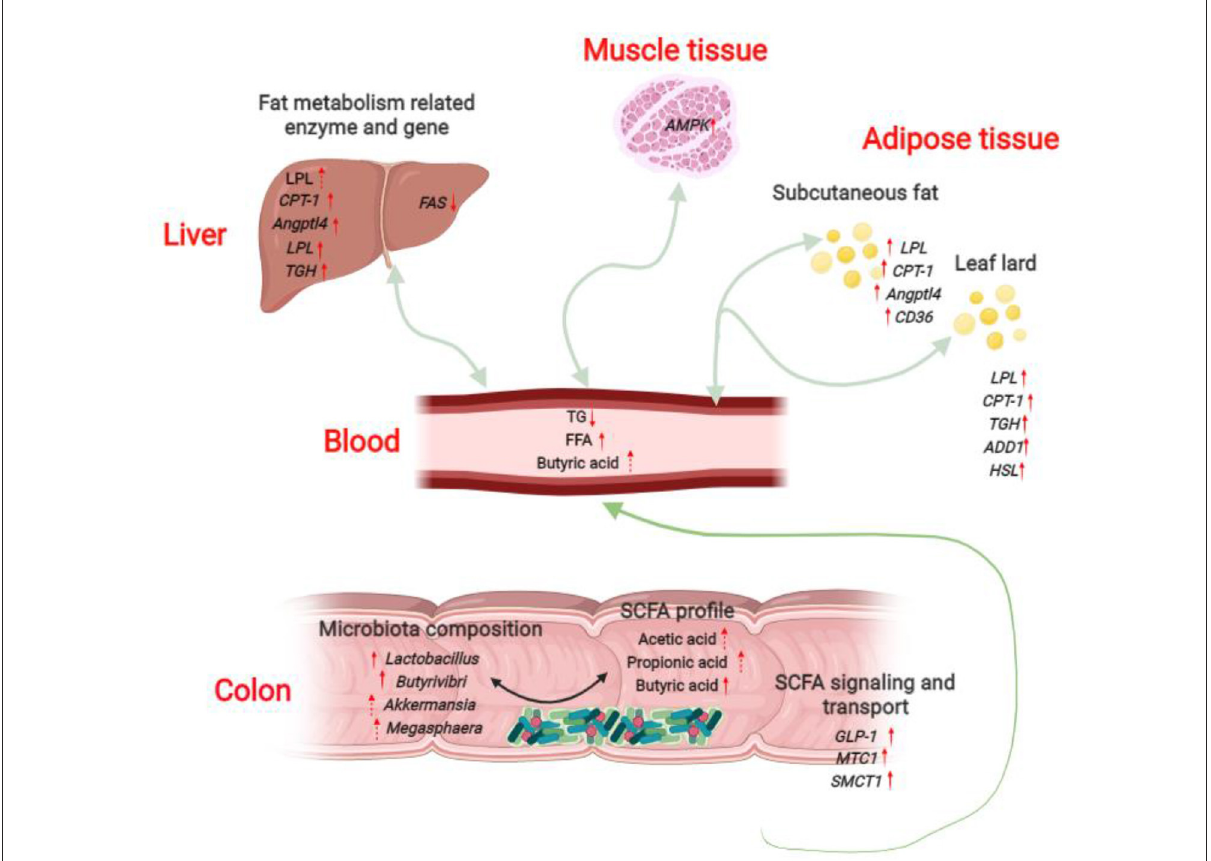
FIGURE8 Potential serum triglyceride-lowering mechanisms of L. delbrueckii - fed growing-finishing pigs. Colonic microbiota modulation (mainly increased the abundance of Lactobacillus , Butyrivibri , Akkermansia and Megasphaera ) after L. delbrueckii administration increased the concentrations of acetic acid, propionic acid and butyric acid. SCFAs produced in colon are rapidly absorbed and transported into blood through the transporters (up-regulation of MTC 1 and SMCT 1) and subsequently taken up and metabolized by body organs (Liver, longissimus dorsi , subcutaneous fat and leaf lard in the study) as substrates or signal molecules, participating in energy and lipid metabolism. SCFAs might mediate the strengthened lipolysis (increased expression of LPL , TGH , HSL ) and fatty acid β -oxidation (up-regulation of CPT -1 and AMPK ) and the weakened fat synthesis (down-regulation of FAS ) in liver, muscle and fat